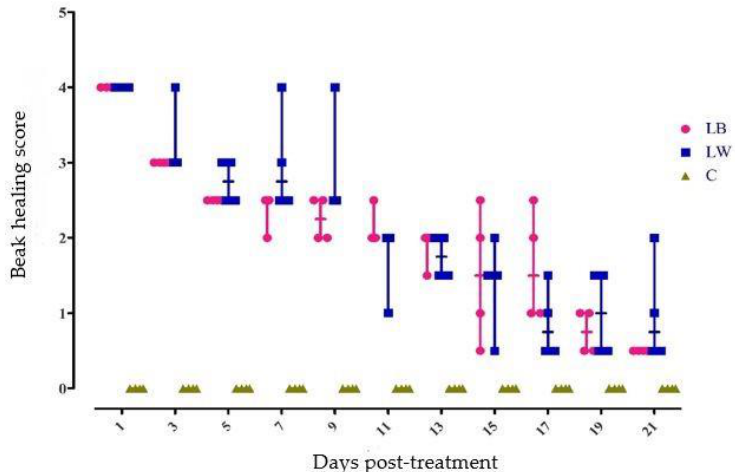
Figure 3. Beak healing scores for infrared beak treated Lohmann Brown-Lite (LB) and Lohmann LSL-Lite (LW) pullets compared to sham treated control (C) pullets (scores identical for C pullets from each strain). Descriptions for histological scores are provided in Table 2. Each marker represents a single bird. Dashes on the lines represent the median score.